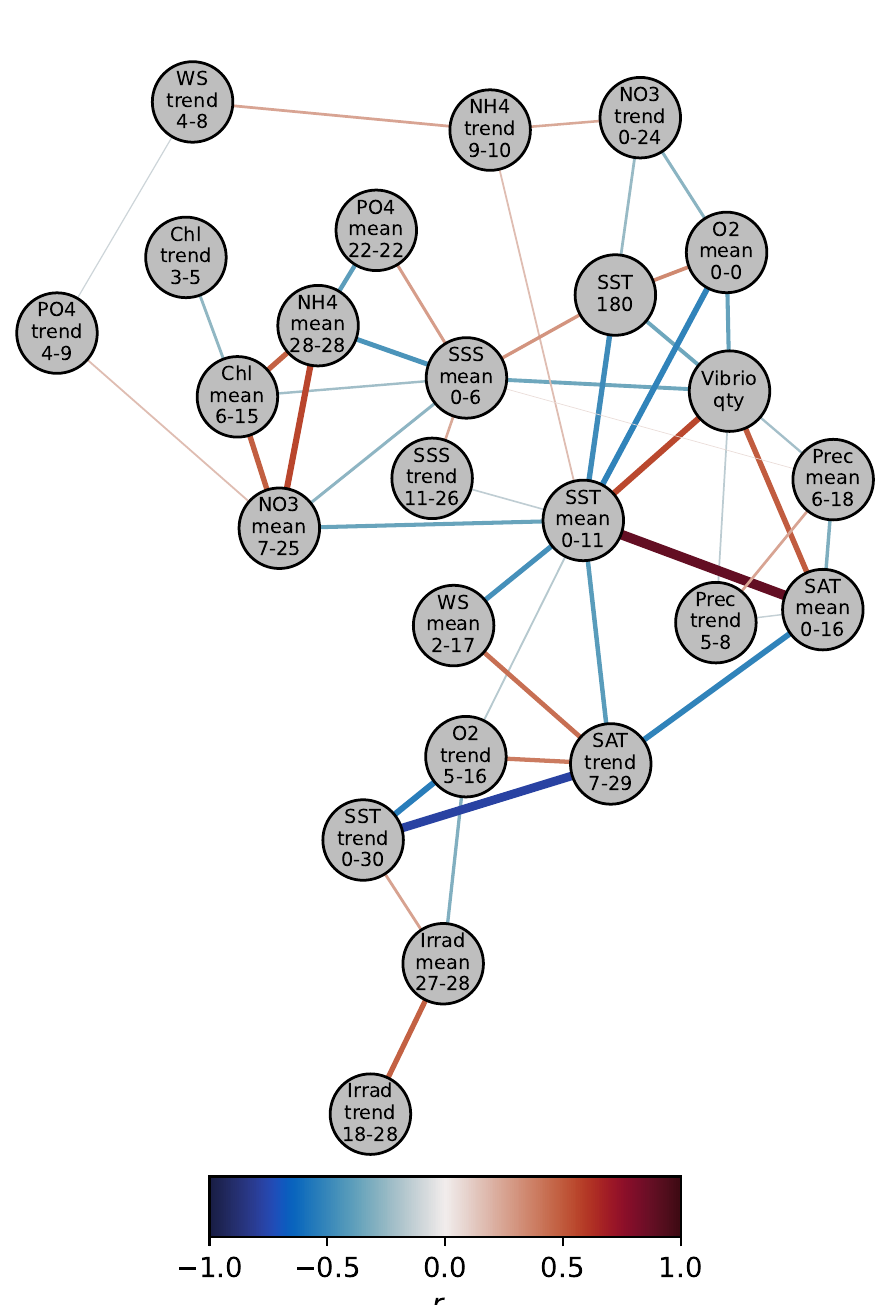
Figure 6. The network between the V. vulnificus quantity and environmental parameters derived with the Saint Nicolas House Analysis (SNHA). Each circle represents a variable (see Table 1 for abbreviations). The last row in the circles represents the time window in days. The edge colour represents Spearman’s rank correlation coefficient between parameters ( r s